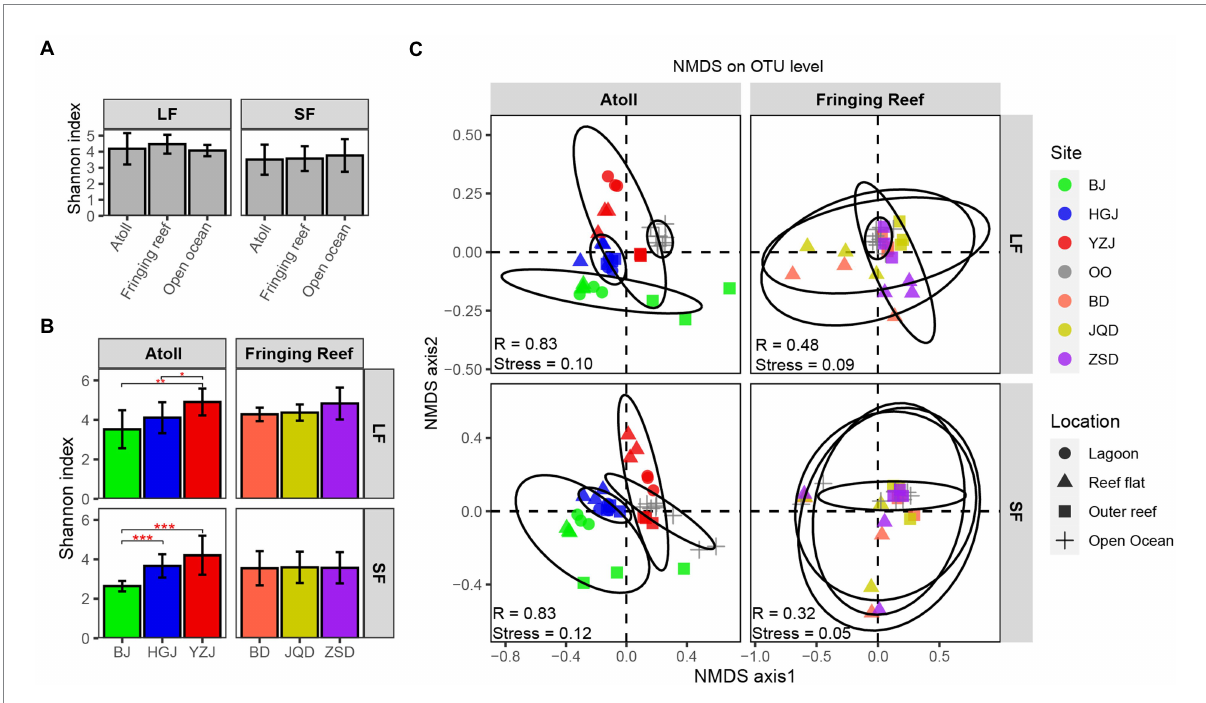
FIGURE 2 Alpha and beta diversity analyzes of bacterial composition. (A) Difference significance of average Shannon index among habitat types in each size fraction, (B) Shannon index difference of different reefs and different fraction sizes. Error bars represent ± SD. (C) Non-metric multidimensional scaling ordinations (NMDS) for bacterial communities (The statistic R represents the separation degree of between-group mean rank similarities used the ANOSIM